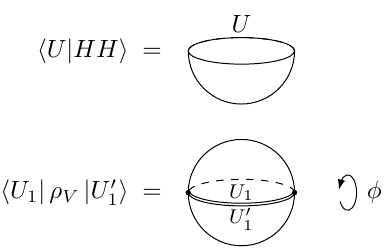
Figure 8 . The Yang-Mills path integral on a hemisphere gives the unnormalized Hartle-Hawking wave function, and the path integral on the sphere computes the square of its norm. Changing the periodicity of the angular coordinate (cid:30) to 2 (cid:25)n yields tr( (cid:26) n ). V of the Hamiltonian on the circle (2.3), one (cid:12)nds that the modular Hamiltonian H V is